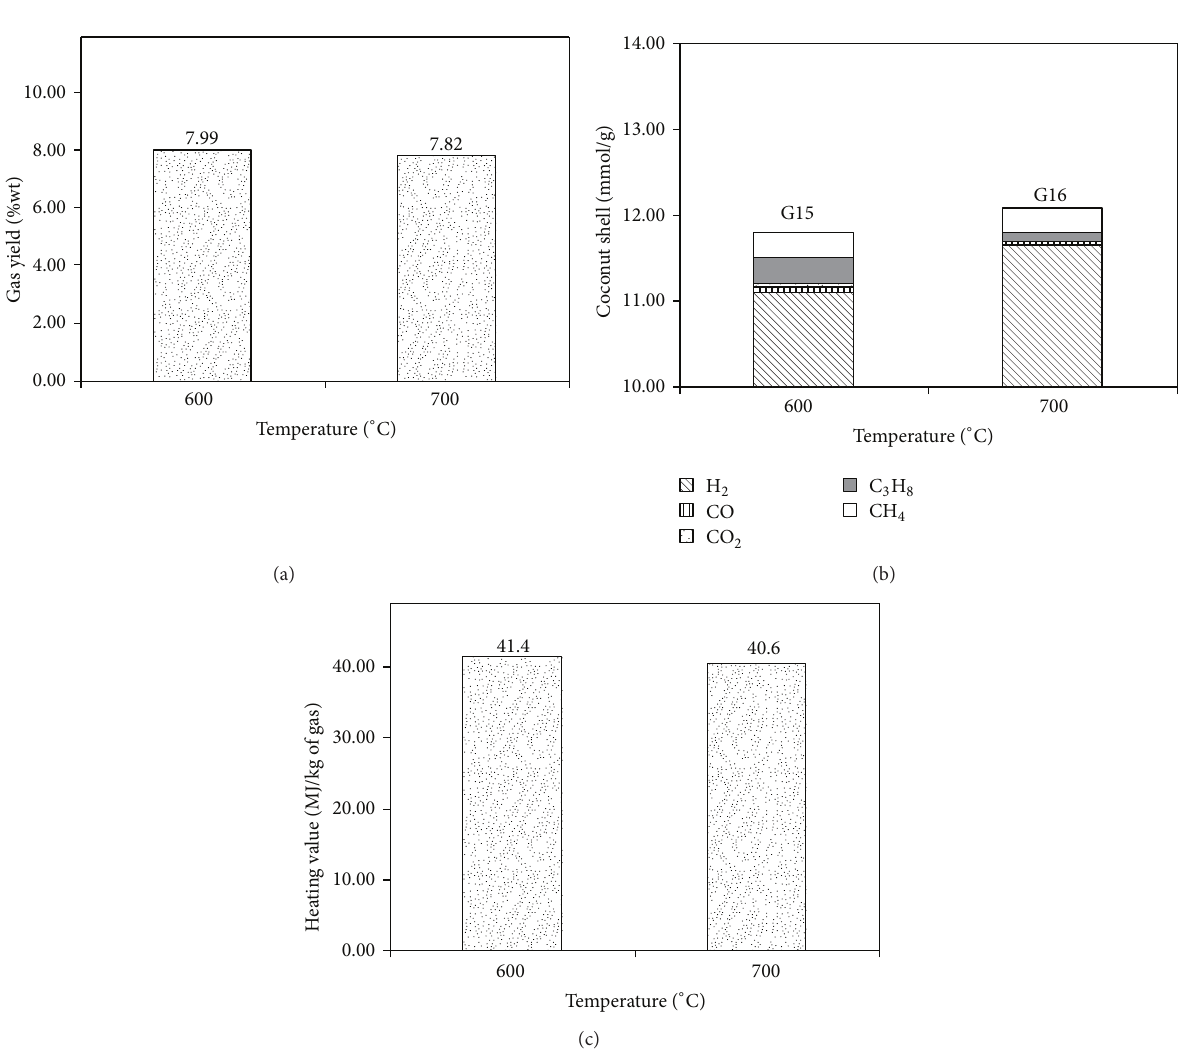
Figure 7: Effect of temperature on (a) gas yield, (b) gas composition, and (c) gas heating value from gasification of coconut shell with carbonization step using 50% CO 2 , chemical ratio of 4.0 for